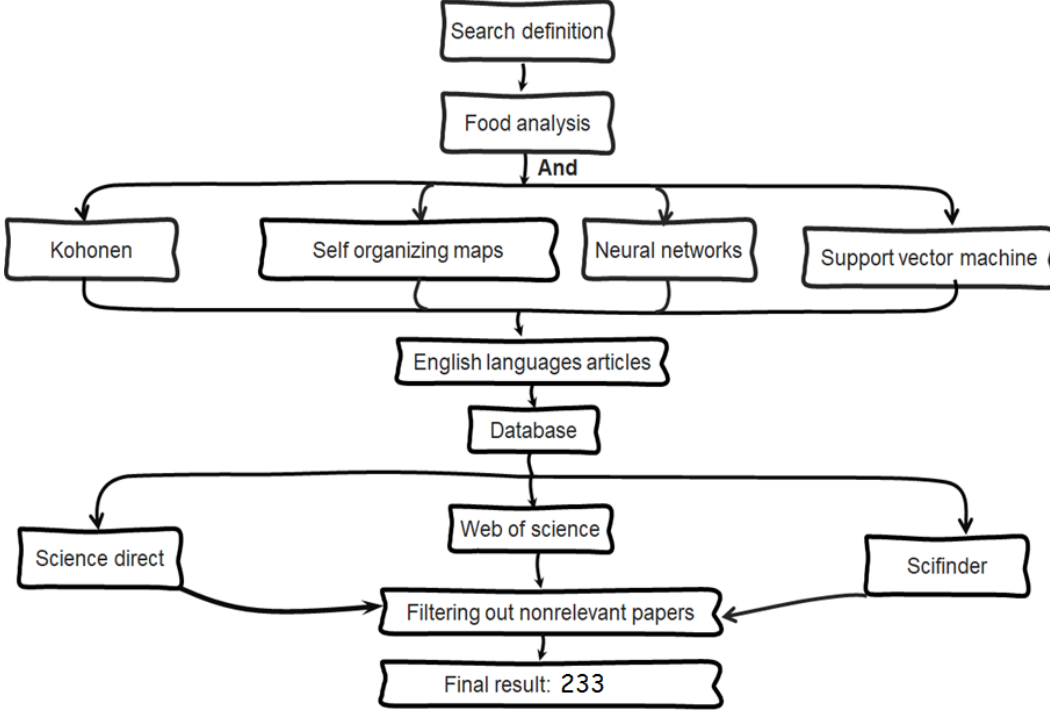
Figure 6. Method utilized for the search and exclusion of papers.